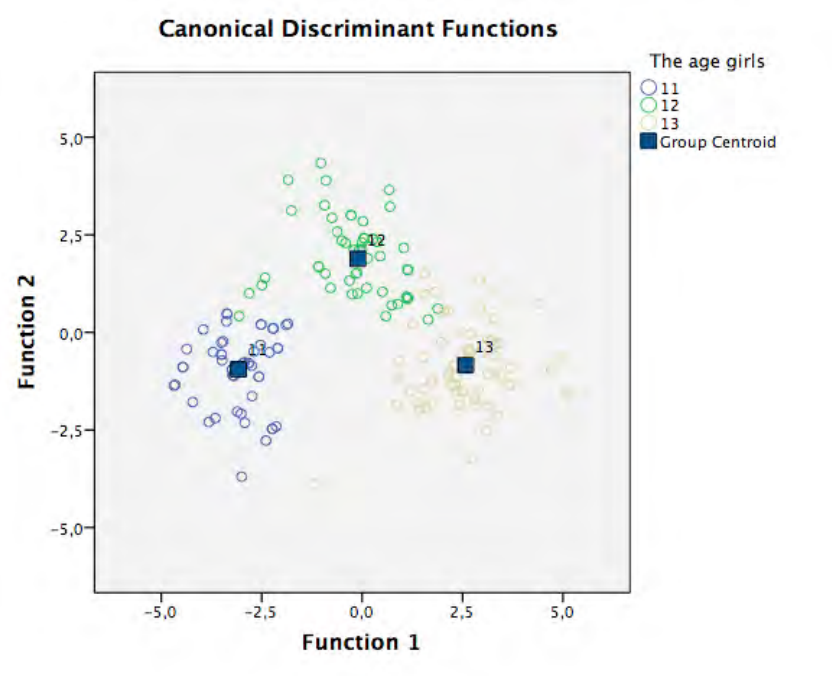
Fig.1 Canonic discriminant functions. Diagram of results of classification of 11-13 yrs girls’ motor fitness, considering the level of physical exercises’ mastering